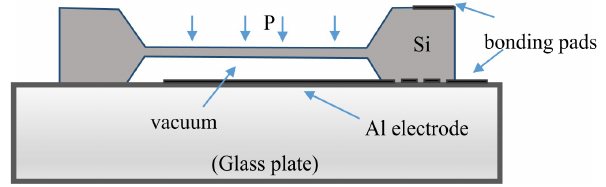
Figure 4. A schematic view of a basic capacitive pressure trans- ducer (Bao,